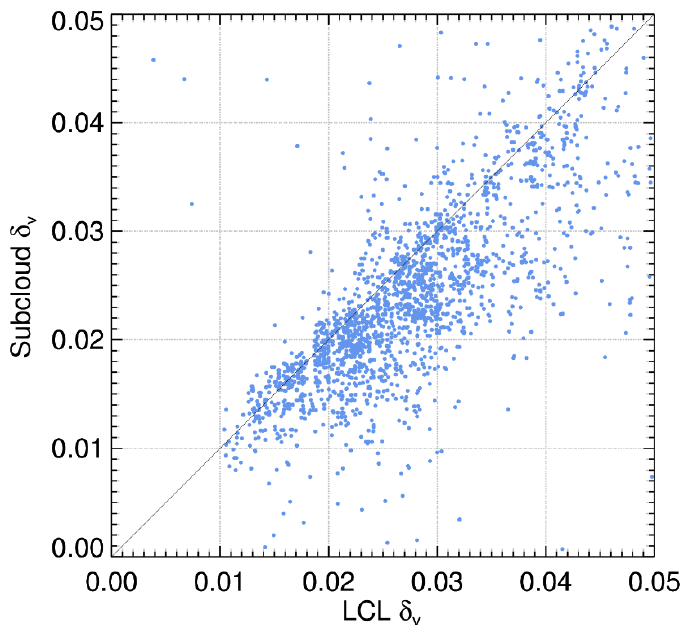
Figure 10. Scatterplot showing the relationship between the values of the volume depolarization ratio δ V at the lifting condensation level (LCL) and at cloud base level based on a total of 1941 shallow cumulus events. Note that out of the 1941 events, 78% are characterized by larger δ V values at the LCL height than that at the cloud base height, exhibiting a gradually increasing condensation with height in the sub-cloud region.